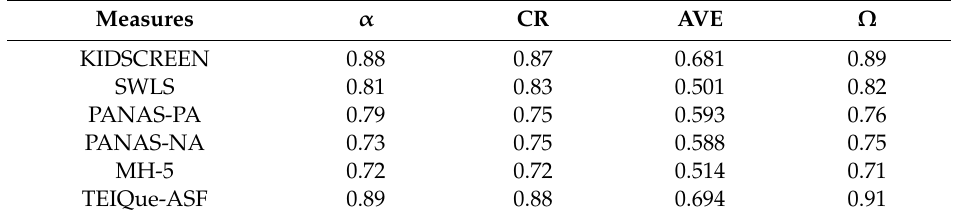
Table 1. Reliability